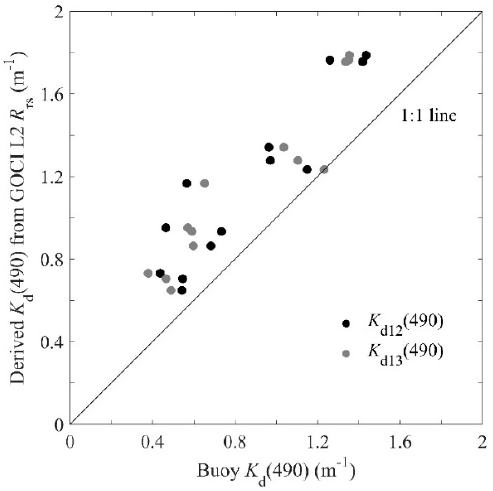
Figure 8. K d ( 490 ) newly derived from GOCI L2 R rs by NDRA. Figure 8. K ( 490 ) newly derived from GOCI L2 R rs by d